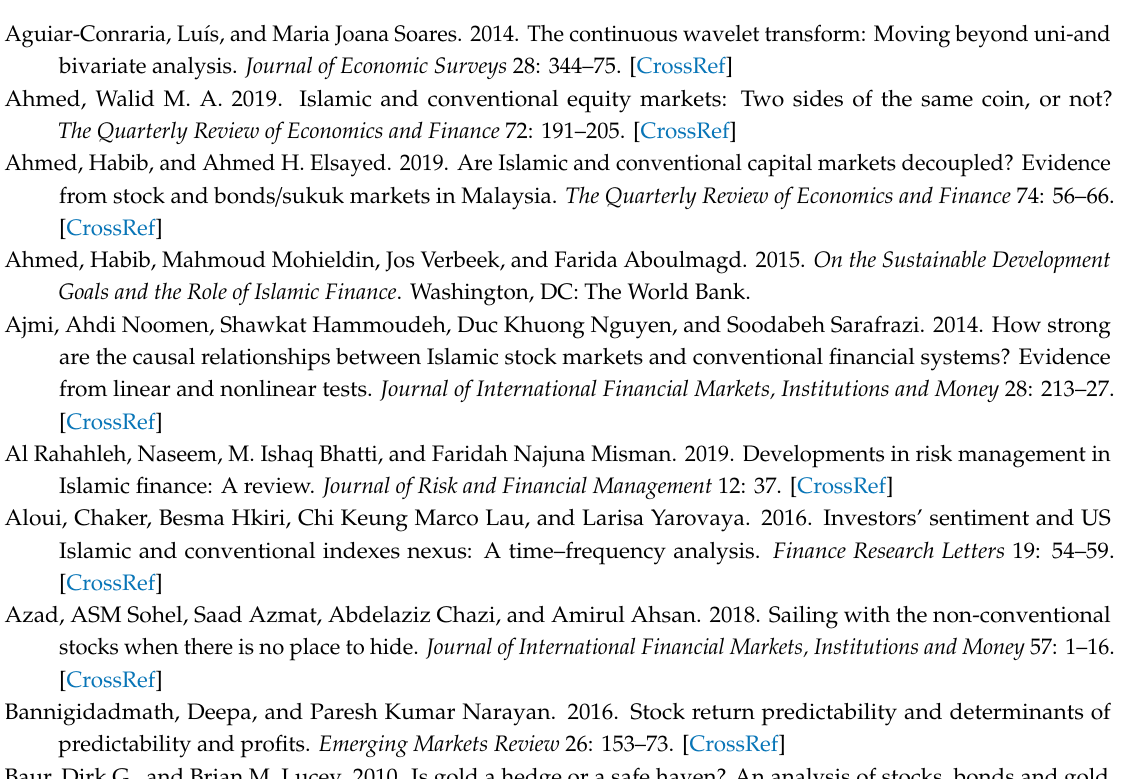
Table A2. Parameter Estimates of New Zealand’s Islamic-conventional ADCC-GARCH model.